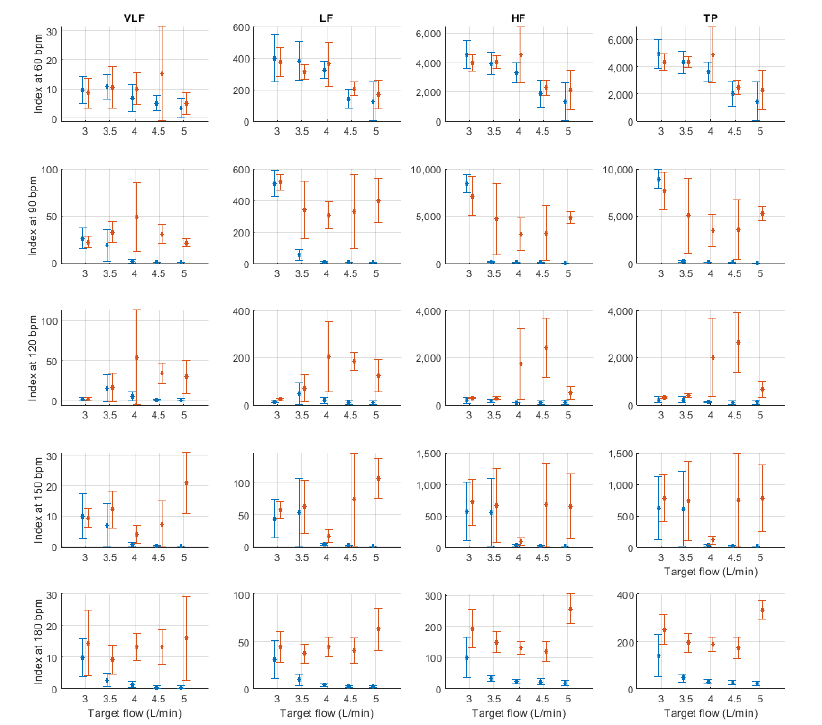
Figure A7. Mean and standard deviation of absolute frequency-domain indices extracted from pulse rate variability under different stroke rates (SR) and target flows (TF, TF above 2.5 L/min) conditions, and measured from the radial (blue) and deep palmar arch (orange) phantoms.